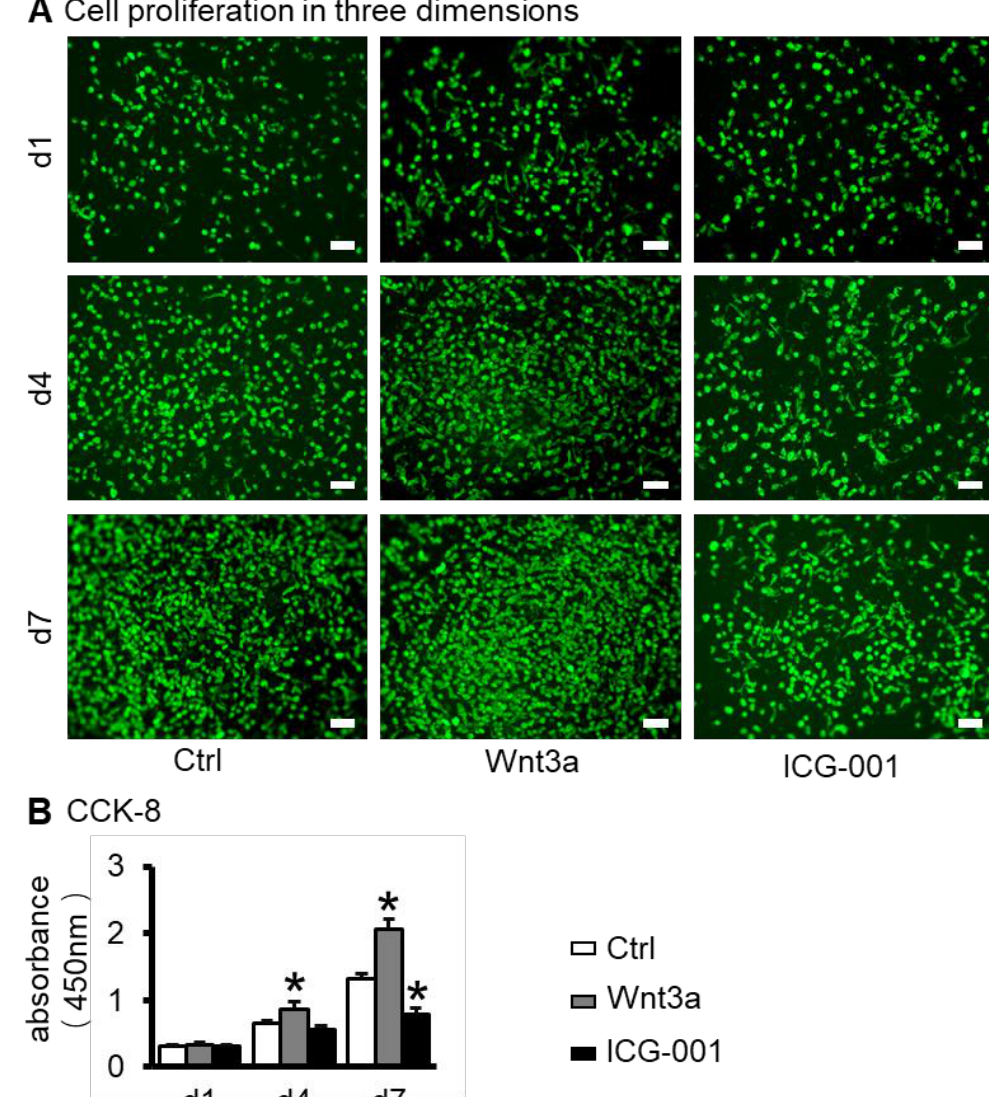
Figure 3. Cell proliferation activity in ST2/GelMA/PCL scaffolds. ( A ) Fluorescence photograph of the 3D scaffold. ST2 cells are labeled with Dio dye (green). ( B ) The cell proliferation detection activity in the scaffold was detected by the CCK-8 kit (n = 5). Compared with the ctrl group, * p < 0.05 by one-way ANOVA. (Scale bar: A, 50 µm).